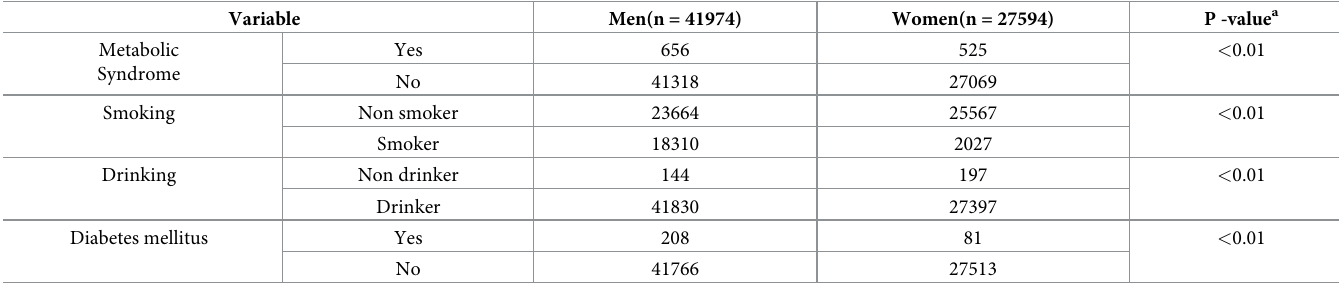
Table 2. Metabolic syndrome and health behaviors in the young age